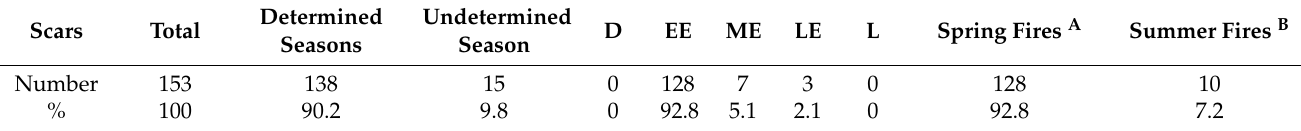
Table 2. Seasonality of fire scars in an Abies religiosa forest in central Mexico.